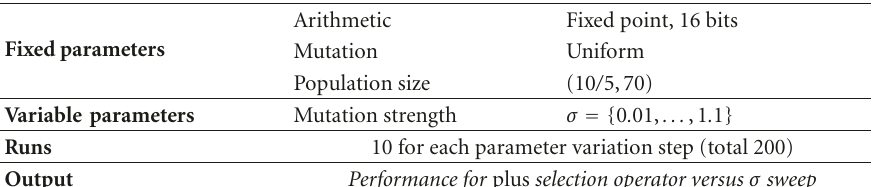
Table 9: Test no. 5. Plus selection operator.